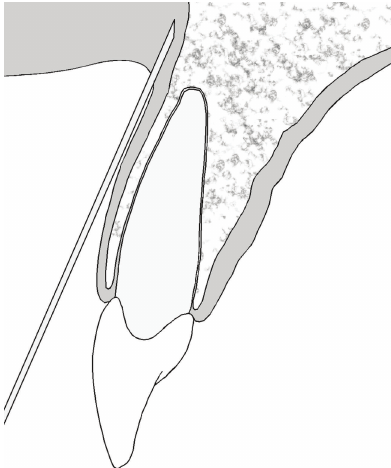
Figure 1: Technique of buccal infiltration anesthesia.